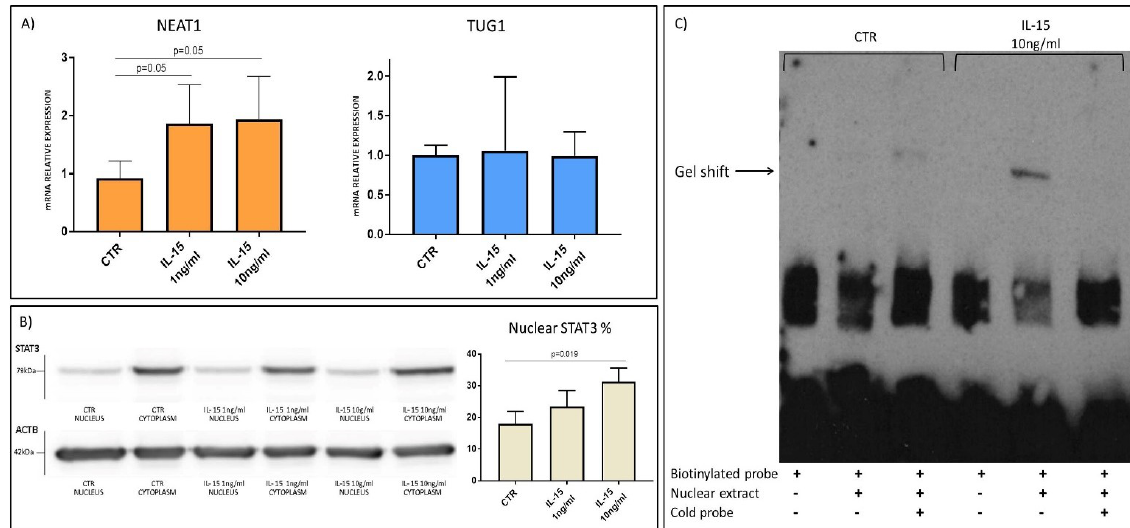
Figure 8. ( A ) NEAT1 and TUG1 mRNA expression level in HIEC-6 cells with or without stimulation with IL-15 ( n = 3). Data are shown as mean value and standard deviation. ( B ) Translocation of STAT3 in the nucleus after IL-15 stimulation. Each sample was normalized on ACTB. Western blot image representative of three independent experiments. ( C ) DNA retardation assay of nuclear protein extracts with biotinylated oligos of NEAT1 promoter region carrying STAT3 putative binding site. Gel shift band is present after IL-15 stimulation and disappears with excess of cold probe. Assay image representative of three independent experiments.